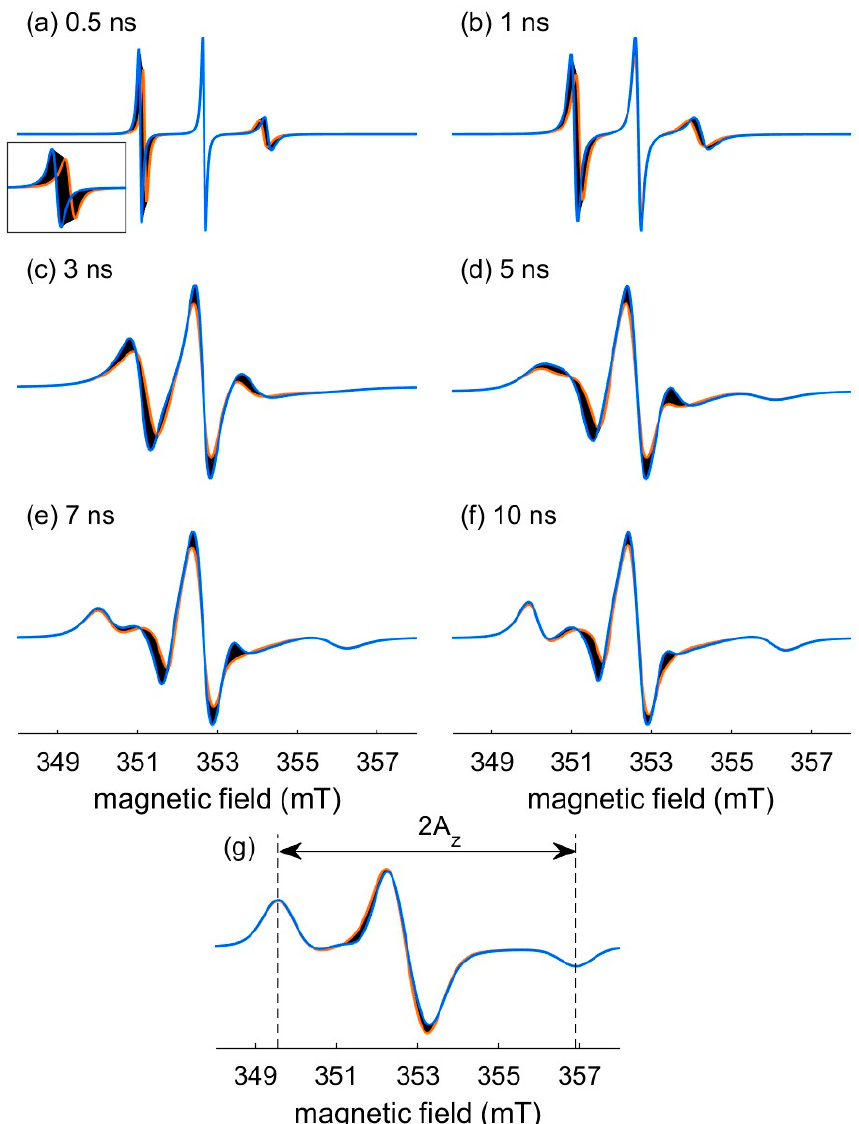
Figure 1. Influence of variations in A xy (0.40 mT ≤ A xy ≤ 0.60 mT) on the nitroxide X-band cw EPR spectral shape for: ( a ) t corr = 0.5 ns; ( b ) t corr = 1 ns; ( c ) t corr = 3 ns; ( d ) t corr = 5 ns; ( e ) t corr = 7 ns; ( f ) t corr = 10 ns; ( g ) frozen solution. Each panel is the superposition of 100 simulated spectra (black traces) with A xy ranging from 0.40 mT to 0.60 mT. The limit spectra obtained with A xy = 0.60 mT = 16.4 MHz and A xy = 0.40 mT = 11.2 MHz are colored (blue trace and orange trace, respectively). Inset in panel ( a ): zoom of the low field line. All the spectra are normalized to their integrated intensity. Parame- ters for the simulations: g x = 2.0084, g y = 2.0061, g z = 2.0022, A z = 3.66 mT = 102.6 MHz, at 9.9 GHz, no additional broadening.